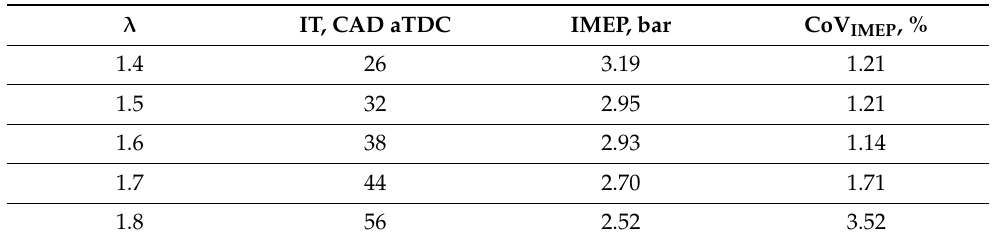
Table 3. Main technical characteristics of the experimental points chosen to develop and test the methodology proposed in the present